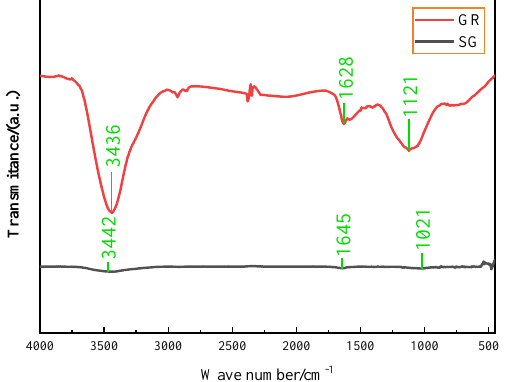
Figure 4. Fourier infrared spectra of SG and GR powders.